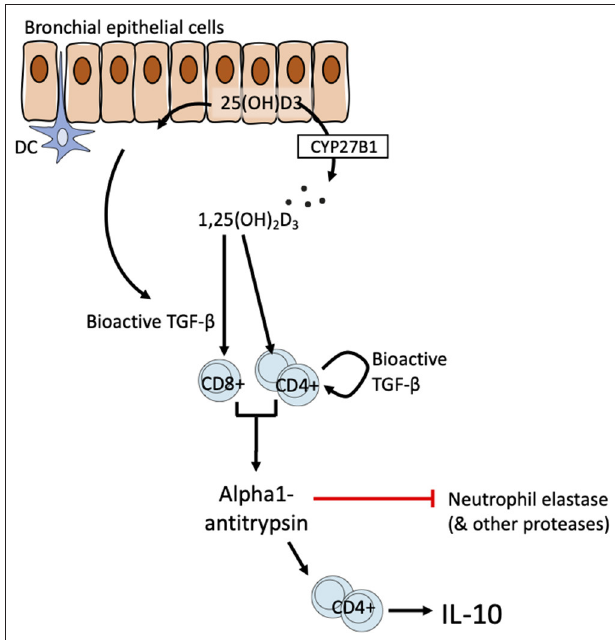
FIGURE 6 | Schematic of proposed T cell-epithelial cell interaction on the vitamin D-TGF- β -AAT